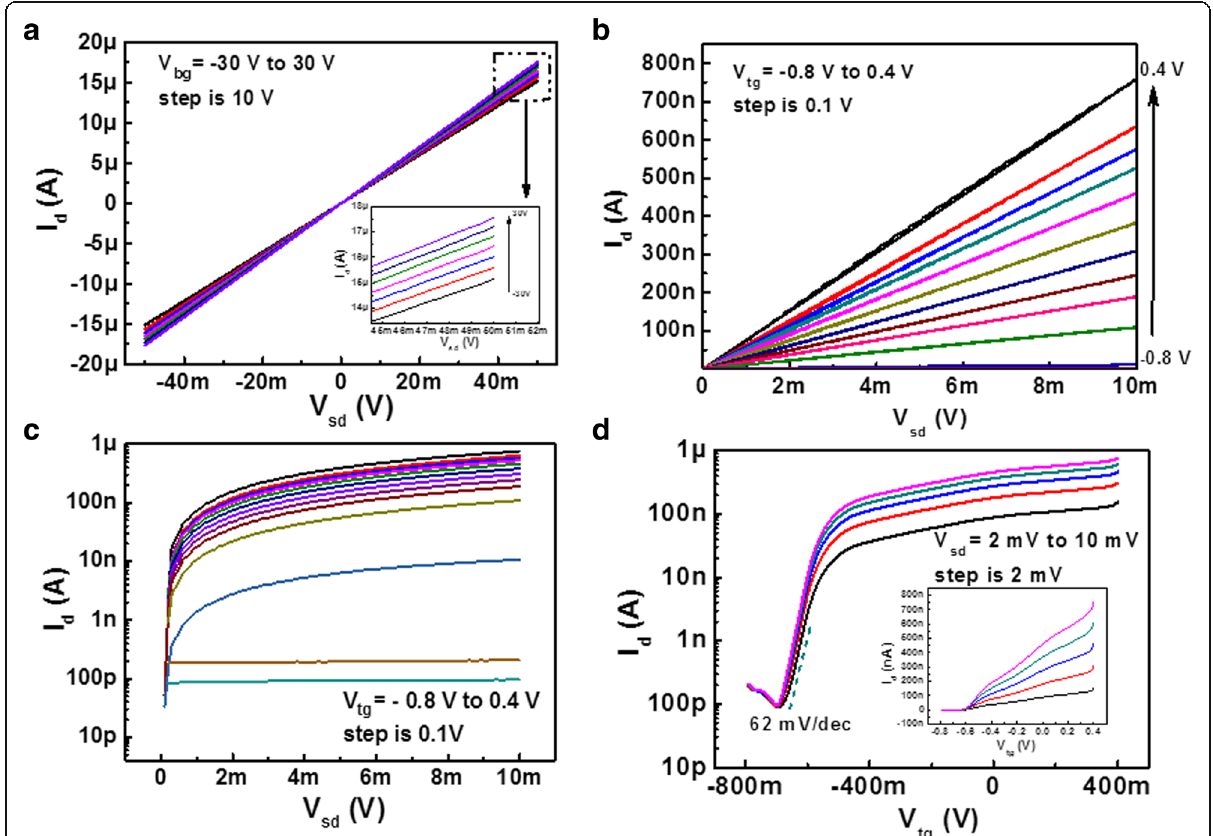
Fig. 2 Output and transfer characteristic of SnSe 2 FET measured in the dark. I d versus V sd characteristic of SnSe 2 FET gated at different back gating voltages V bg ( a ), at different top gating voltages V tg in a linear scale ( b ), and at different V tg in a semi-log scale ( c ). I d versus V tg characteristic of SnSe 2 FET with V sd ranging from 2 mV to 10 mV in steps of 2 mV drawn in a semi-log scale, the inset is a linearly-scaled plot of I d -V tg characteristic ( d